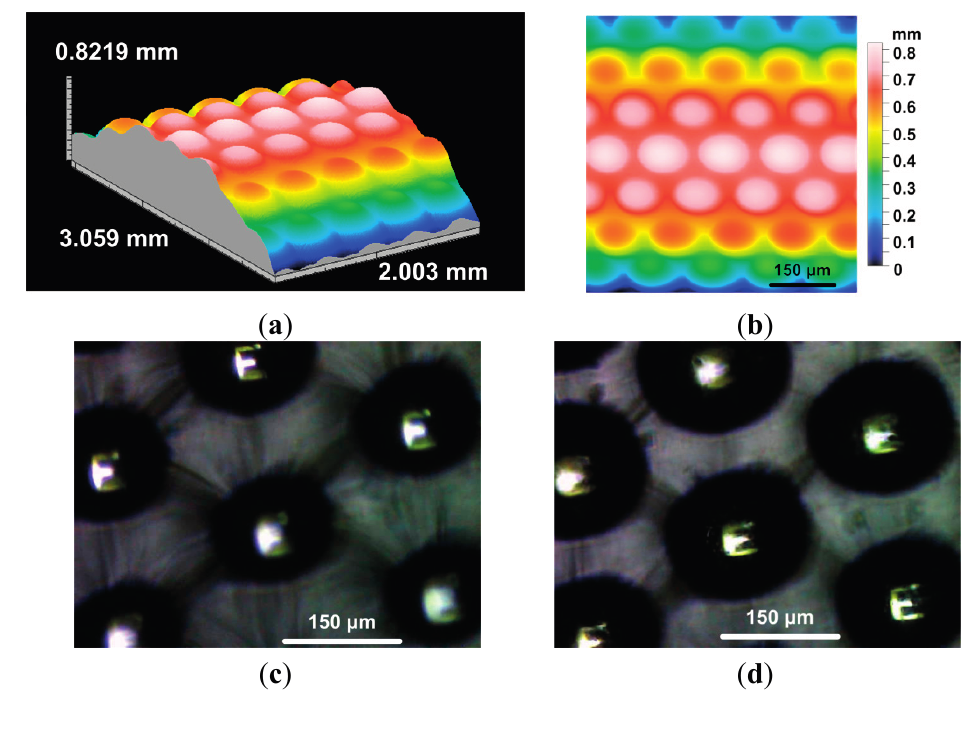
Figure 20. Three-dimensional microlens array. ( a ) Three-dimensional scanning of profile; ( b ) top view; and ( c , d ) two different views at two different locations. Reproduced with permission from Taylor & Francis, 2014